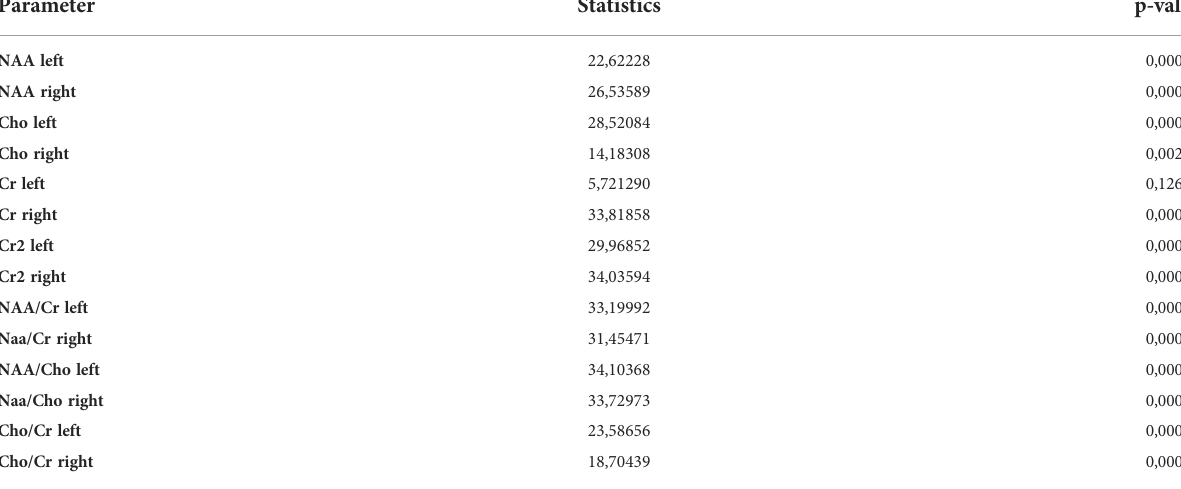
TABLE 6 Values of the Kruskal-Wallis rank test for parameters of proton spectroscopy of the brain of patients with type 1 diabetes mellitus. Parameter